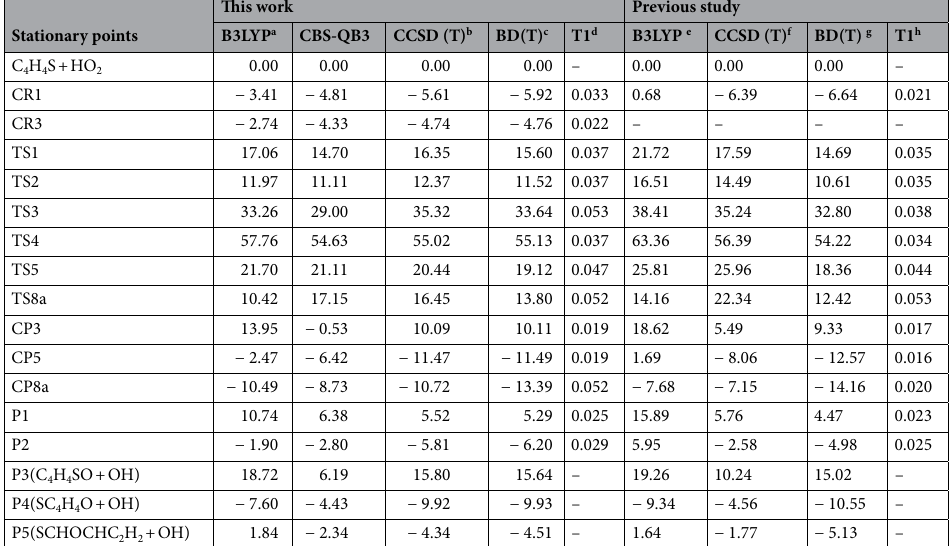
Table 2. Relative energies (in kcal mol −1 ) of the reactants, products, intermediates, and transition states involved in the bare reaction at different levels of theory. a B3LYP method in conjunction with 6–31 + G(d,p) basis set. b CCSD(T) single point on the optimized structure of the B3LYP/6–31 + g(d,p) level. c BD(T)/6– 31 + G(d,p)//B3LYP/6–31 + G(d,p) level. d T1 diagnostic values at the CCSD(T)/6–31 + G(d,p) level. e B3LYP method in conjunction with 6–311 + g(d,p) basis set. f CCSD(T)/CC-PV(T + d)Z//B3LYP/6–311 + G(d,p) level. g BD(T)/6–31 + G(d,p)//B3LYP/6–311 + G(d,p) level. h T1 diagnostic values at the CCSD(T)/CC-PV(T + d)Z